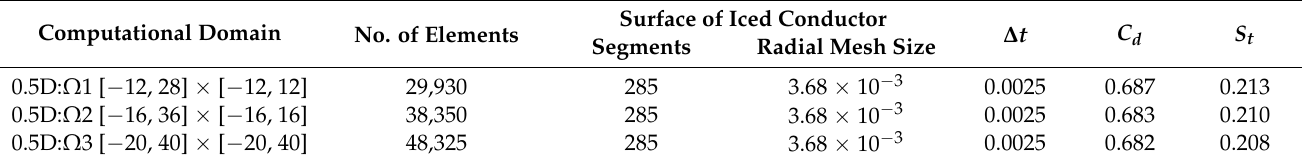
Table 2. Result comparisons of different mesh size.